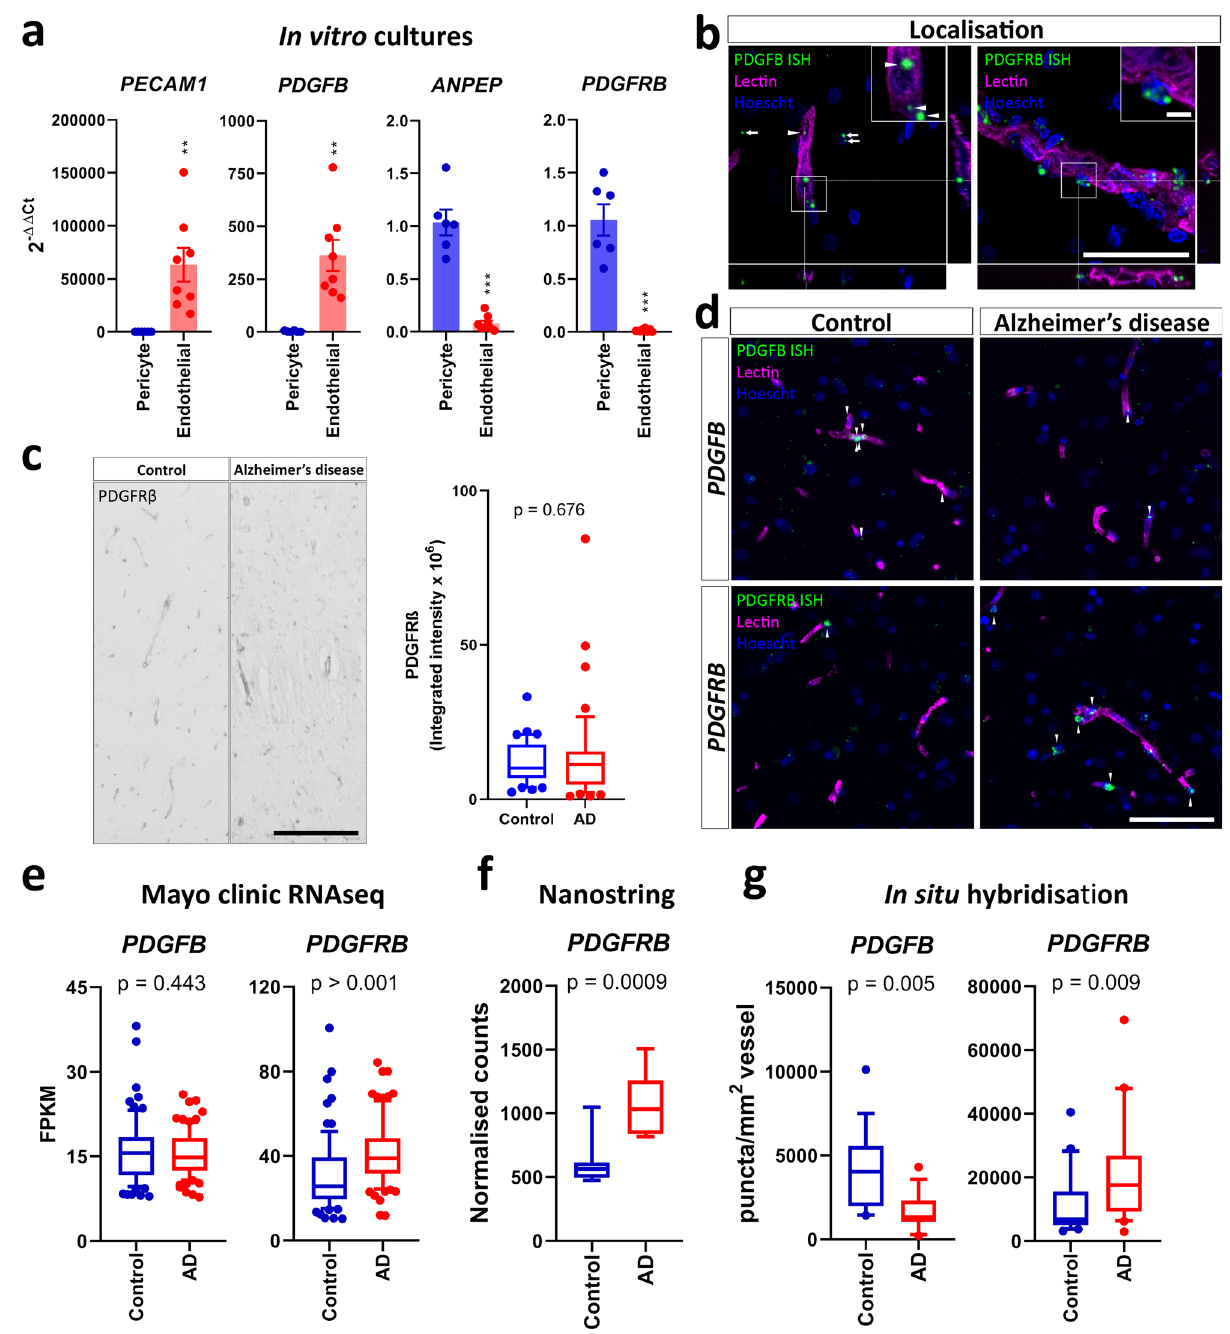
Fig. 1 PDGF-BB:PDGFR β signalling components are altered in the AD brain. Primary human brain pericytes and endothelial cells were isolated and PDGFR β signalling components were measured by qPCR. a qPCR of lineage markers ( PECAM1 and ANPEP ) and PDGF-BB:PDGFR β signalling components in isolated human brain endothelial cells and pericytes. N = 6 – 8. ** p <0.01, *** p <0.001, unpaired t test. Tissue microarray blocks containing control and AD cores were stained with PDGFR β ( n = 41 – 42), or UEA lectin to label blood vessels and RNAscope probes against PDGFB and PDGFRB ( n = 14 – 28). b Confocal images of PDGFB and PDGFRB probes relative to lectin in epilepsy biopsy cortex. Scale bar = 100 μ m, inset = 10 μ m. c Representative immunohistochemical staining for PDGFR β in control and AD cortex, and quanti fi cation of staining intensity. Scale bar = 100 μ m. d Representative images of PDGFB and PDGFRB ISH in AD and control cortex. Scale bar = 100 μ m. e Expression of PDGFB and PDGFRB in bulk RNAseq data of control and AD temporal cortex, derived from Allen et al. 51. n = 80, unpaired t test. f PDGFRB expression in frozen temporal cortex tissue from control and AD brains, detected by Nanostring. n = 9, unpaired t test. g Quanti fi cation of PDGFB and PDGFRB puncta associated with lectin-positive blood vessels. n = 14 – 21, unpaired t test. PDGF-BB causes the internalisation and degradation of screen for phosphorylation in key intracellular pathways using an PDGFR β . To determine the effect of PDGF-BB on PDGFR β antibody array, and detected that ERK and Akt were the pre- dynamics, kinetic data were gathered on PDGFR β expression, dominant pathways activated in pericytes, with lesser activation distribution and localisation with endosomes. PDGF-BB of GSK-3 α / β and WNK1 (Fig. 2j – l).